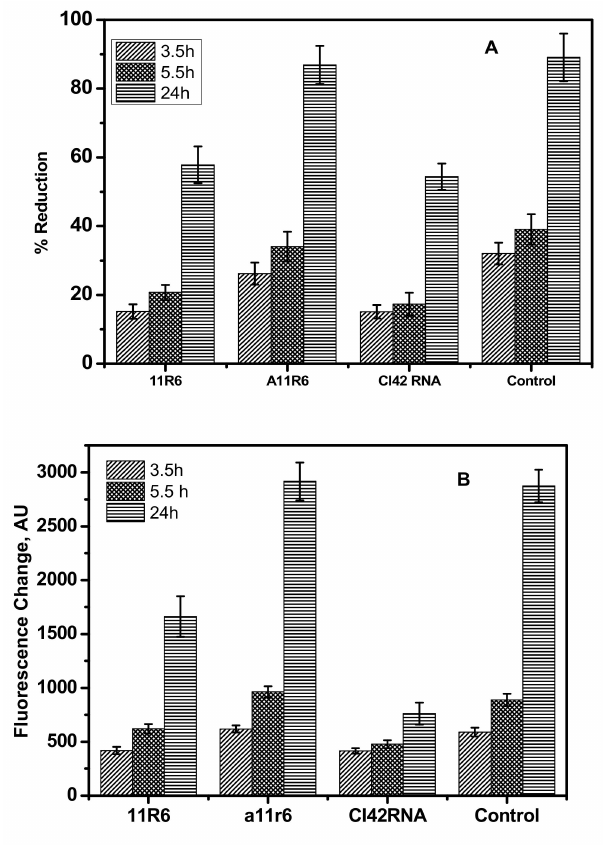
Figure 1. ( A ) Changes in the percentage reduction (from the absorption) in reduced Alamar blue at 570 nm in the presence of 4T1-Luc2 untreated cells or incubated with anti-VCAM-1 ssDNA full length (11R6), truncated aptamer (A11R6), or anti-IL4R α RNA aptamers (Cl42RNA) for 3.5, 5.5 and 24 h. ( B ) Change in the fluorescence intensities of reduced alamar blue at 590 nm in the presence of 4T1-Luc2 cells untreated or incubated with anti-VCAM-1 ssDNA full length (11R6), truncated aptamer (A11R6), or anti-IL4R α RNA aptamers (Cl42RNA) for 3.5, 5.5 and 24